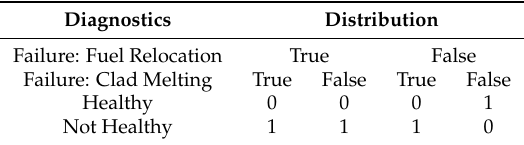
Table A4. Conditional probability table for diagnostics